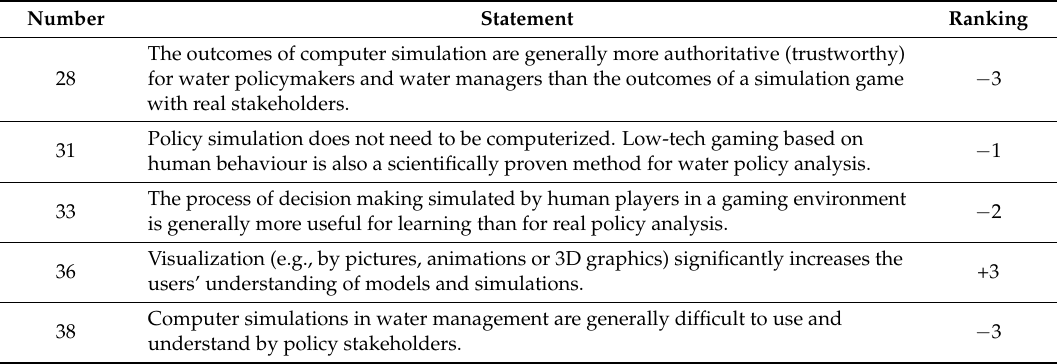
Table 10. Distinguished statements about MSG in frame